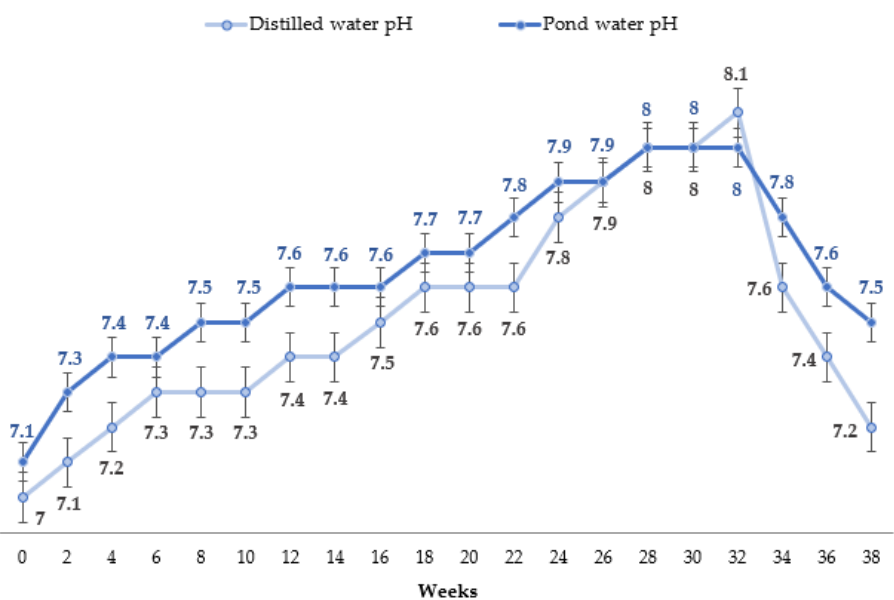
Figure 4. Values of pH in the leachates from tires measured in distilled water and recipient water.